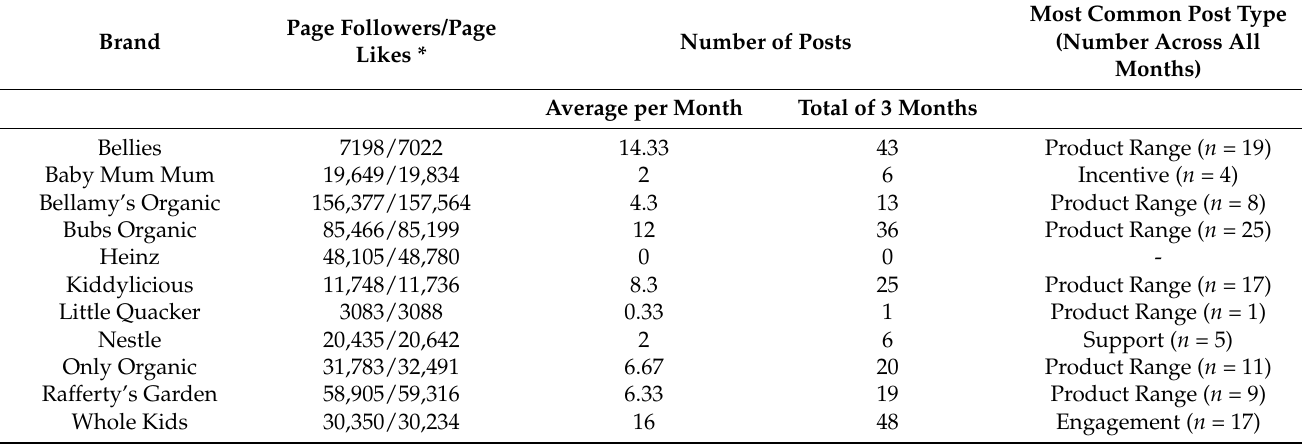
Table 3. Facebook posts by commercial complementary food brand pages, 10 June–11 September